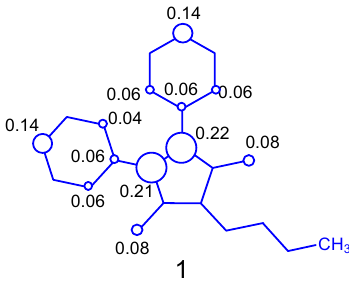
Figure 4. Spin densities contribution of phenylbutazone cation free radical.